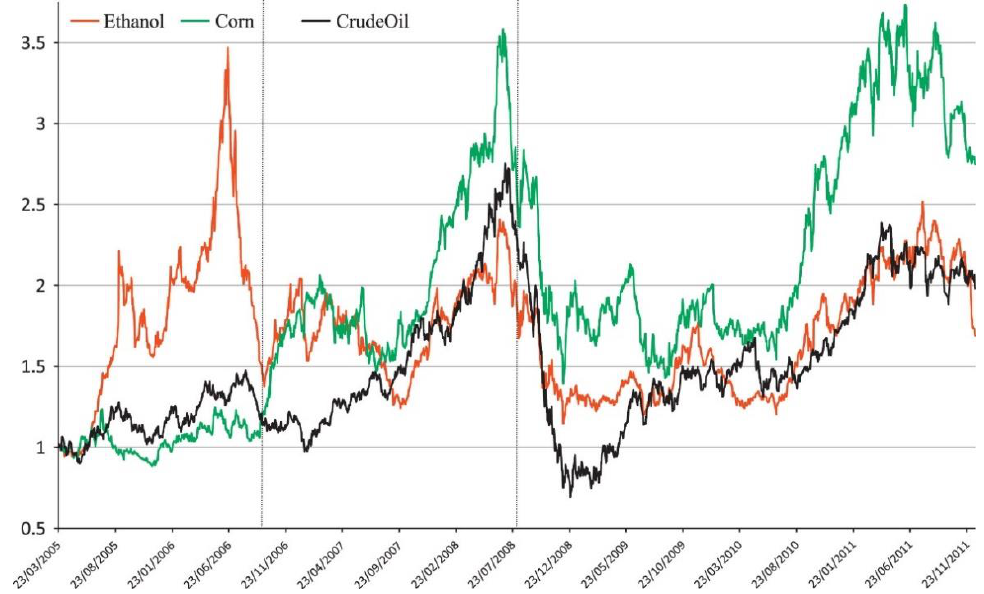
Figure 5. Evolution of the ethanol, corn, and crude oil prices. Source: [38].